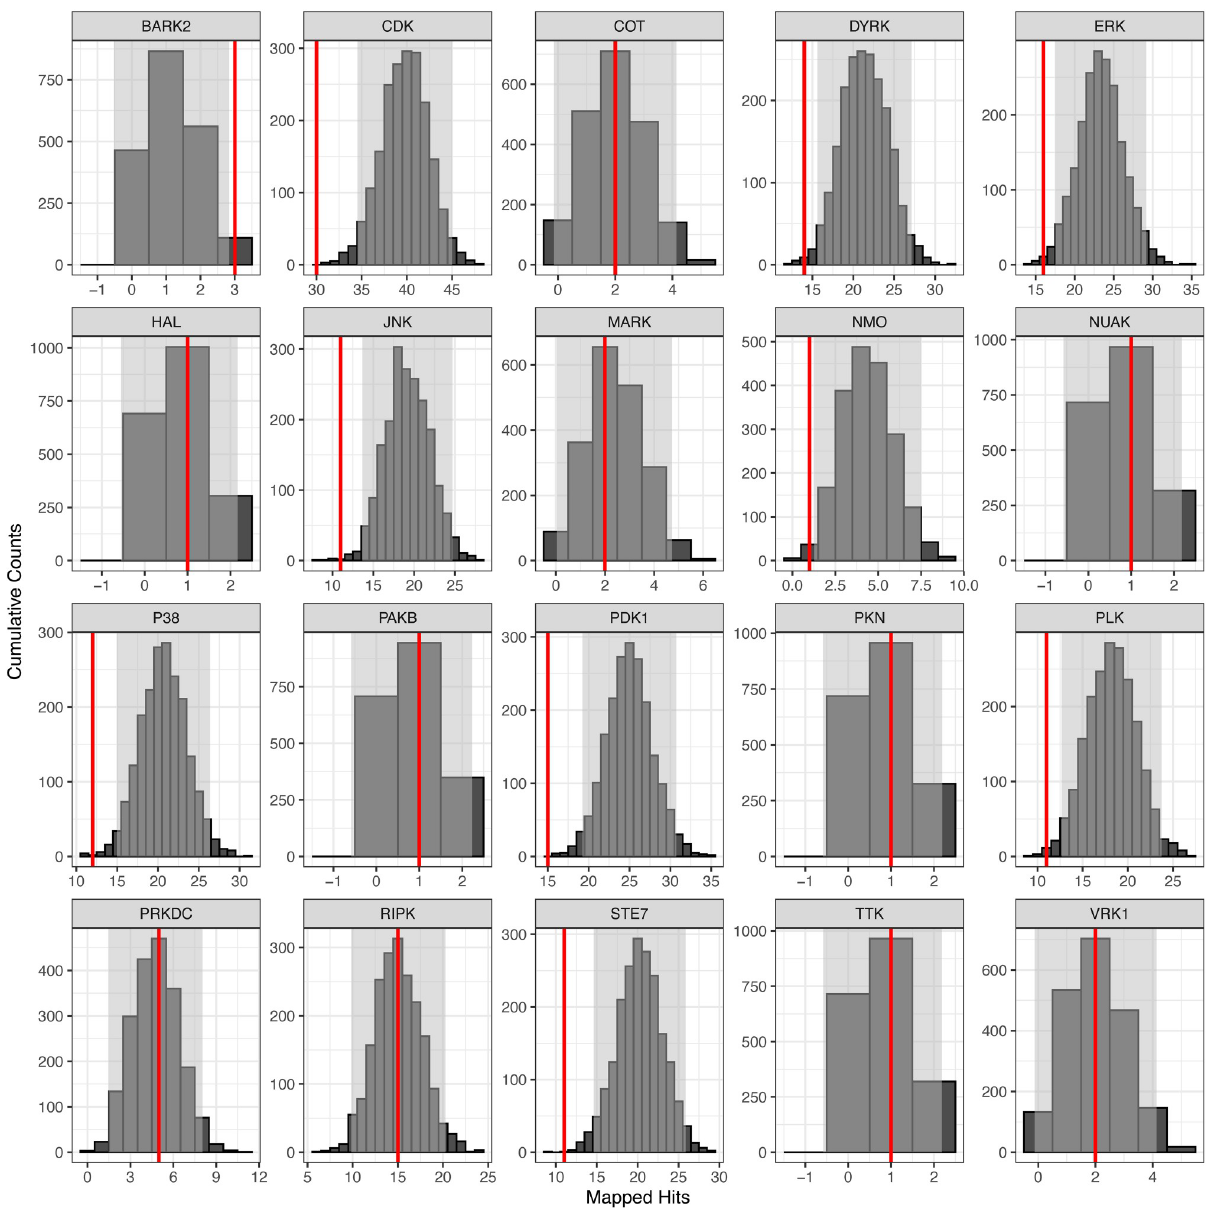
Fig 4. Observed frequency of selected kinases relative to expected random sampling distribution in female vs. male DLPFC. Examples are shown for kinases identified in the reporter peptides more than by random chance alone (e.g., BARK2), less than by random chance (e.g., ERK, CDK, JNK), as well as for kinases that were not identified to be significantly relevant (e.g., COT, MARK, RIPK). KRSA was performed with 2000 iterations and histograms were automatically generated. Gray areas indicate ± 2 standard deviations from the expected distribution mean. The red line indicates the number of mapped peptides for the corresponding kinase based on one of the log2 fold change cutoffs (0.2 shown here). The Z scores for each kinase are derived by calculating how many standard deviations the red line is away from the